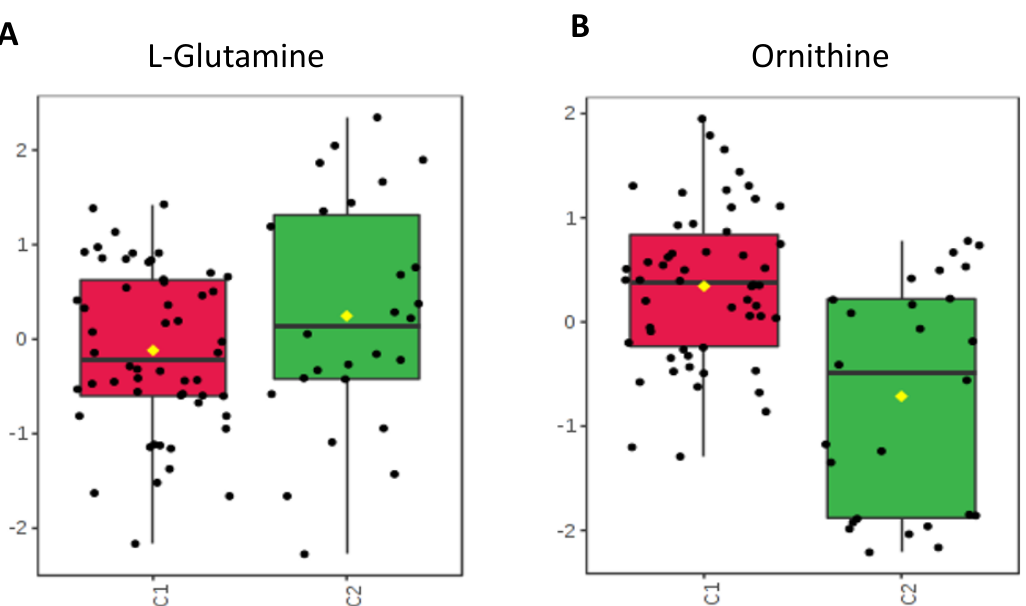
Figure 5. Neurotransmitters. Fecal concentrations compared between groups C1 and C2. ( A – D ) Neurotransmitters falling within the serotonin pathway: tryptophan ( p = 0.047), 5-HT ( p = 0.17), serotonin ( p = 0.82), dopamine ( p = 0.40). ( E ) GABA ( p = 0.001), a neurotransmitter which is produced in high quantities within enterocytes.